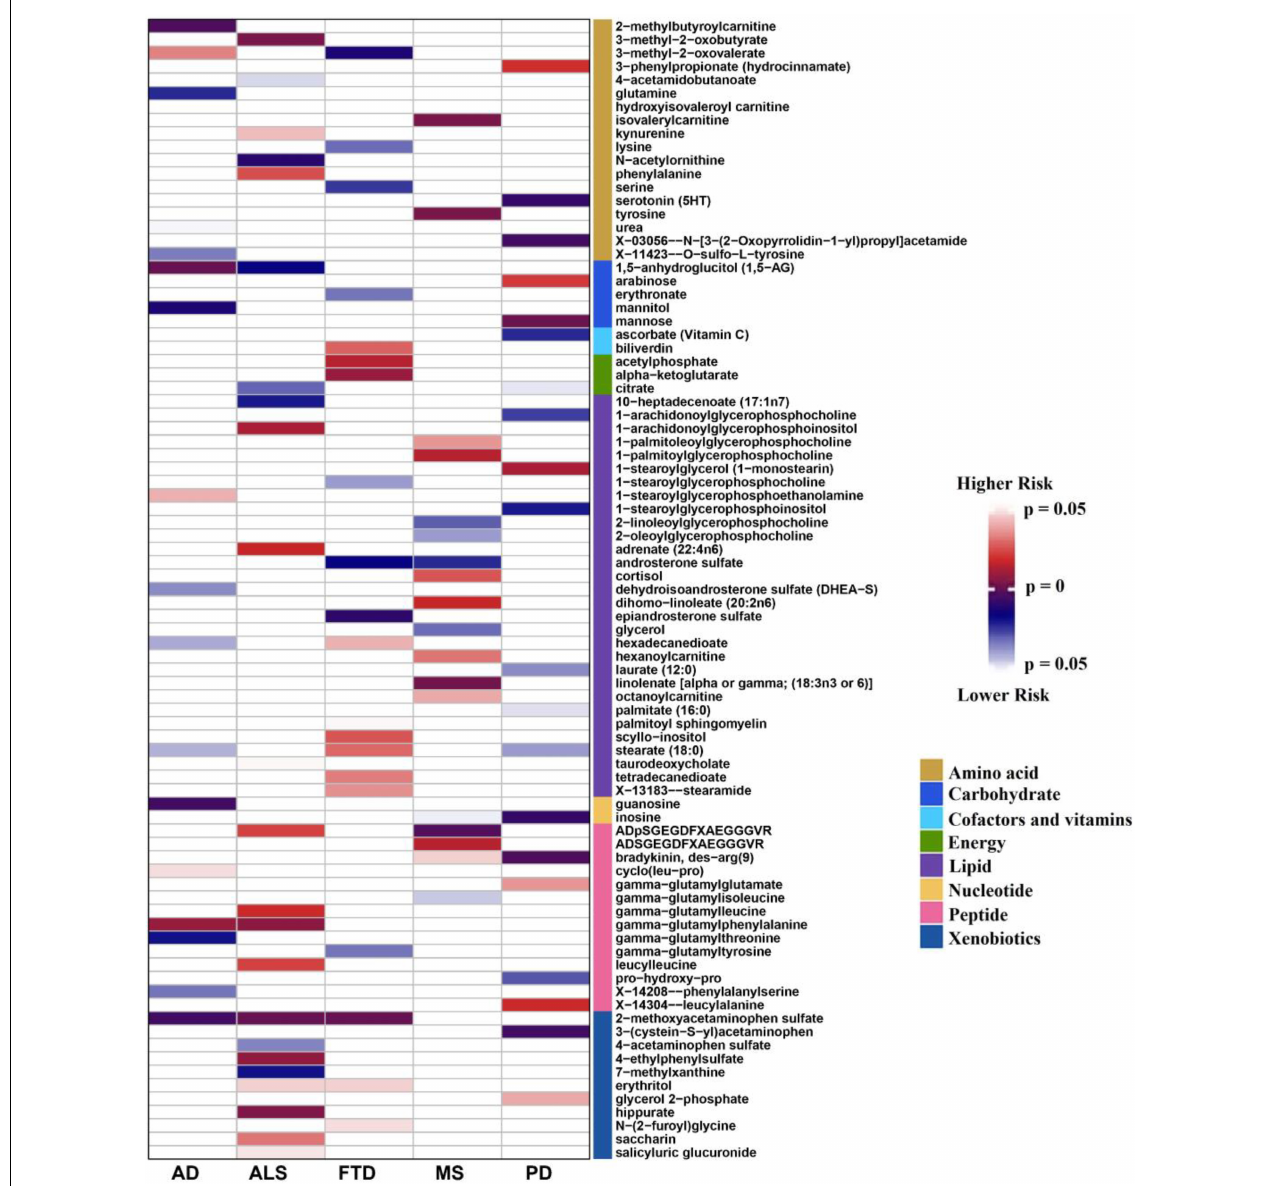
FIGURE 1 | Identified causal associations between known metabolites and the risk of five neurodegenerative diseases using the IVW MR analysis. IVW, inverse-variance weighted; AD: Alzheimer’s disease; ALS: amyotrophic lateral sclerosis; FTD: frontotemporal dementia; PD: Parkinson’s disease; MS: multiple